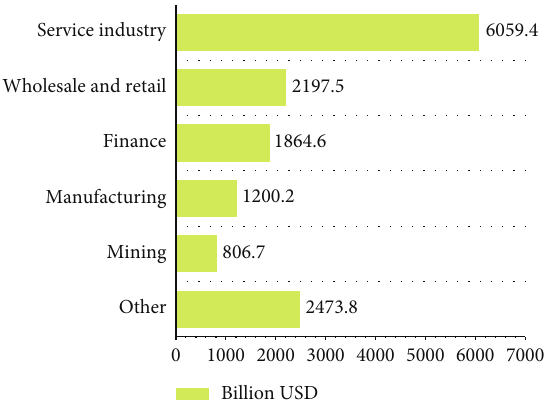
Figure 6: Industry distribution of China ’ s direct investment in Central Asia in 2020.